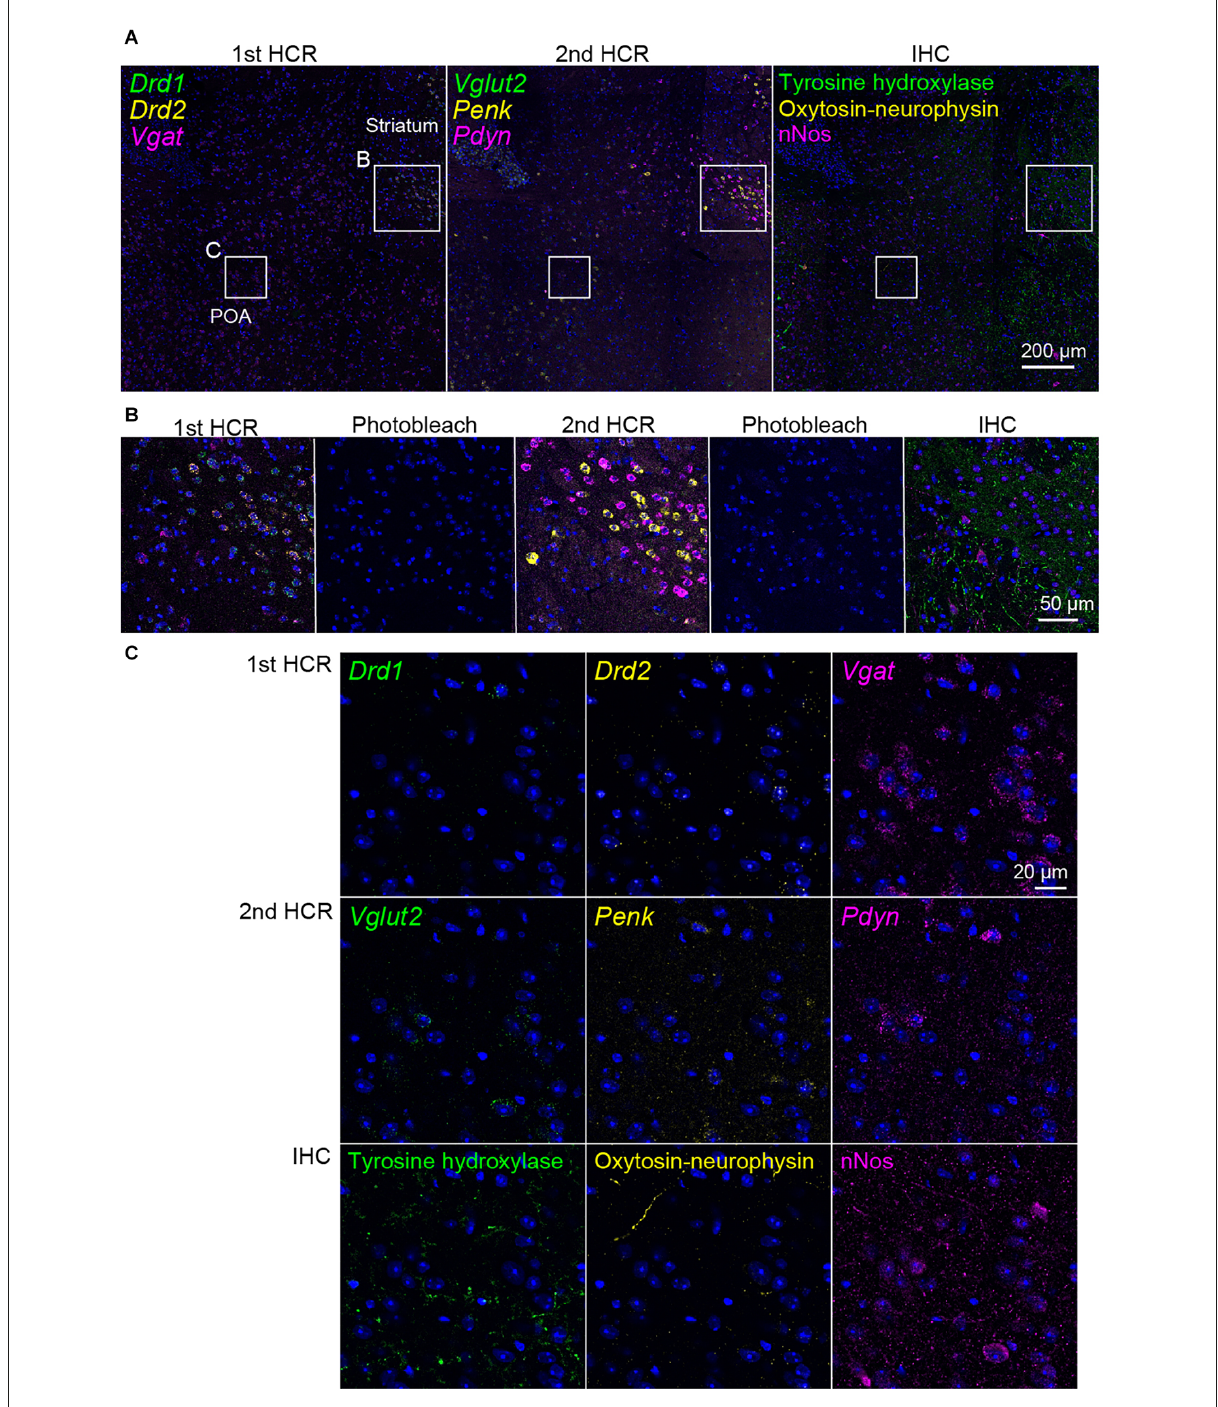
FIGURE6 Representative photomicrographs of two-round ISH-IHC. The first HCR visualized Drd1 (green, S41-SaraFluor488), Drd2 (yellow, S23-Atto550), and Vgat (magenta, S68-Cy5) mRNAs. The second HCR visualized Vglut2 (green, S45-SaraFluor488), Penk (yellow, A161-Atto550), and Pdyn (magenta, S85-Cy5) mRNAs. In the IHC, tyrosine hydroxylase, oxytocin-neurophysin, and nNos were visualized by Alexa488, Alexa568, and Alexa647 secondary antibodies, respectively. (A) Merged low-magnification images of mouse sections, including the preoptic area (POA) and striatum. Rectangles indicate the regions shown in (B,C) . Scale bar: 200 µ m. (B) Merged, sequential images of the first HCR, photobleached image, the second HCR, photobleached image, and IHC. Scale bar: 50 µ m. (C) Separate high-magnification images of each molecule. Scale bar: 20 µ